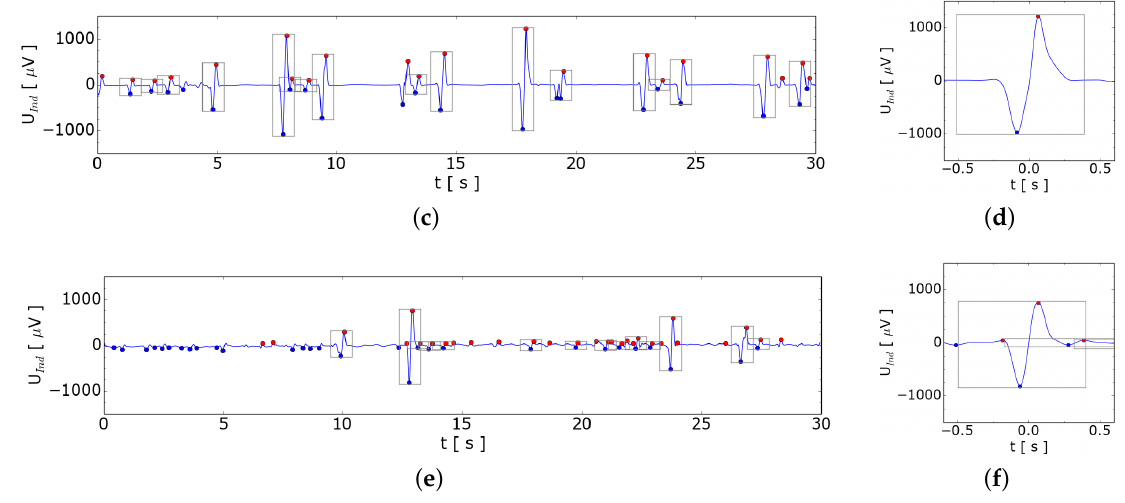
Figure 10. Bubble detection in sodium at rest and in motion, driven by an electromagnetic (EM)-pump. ( a , b ) Measured voltage when sodium is at rest with zoom at t = 31.4 s; ( c , d ) Measured voltage for sodium velocity of 6 cm/s with zoom at t = 17.8 s; ( e , f ) Measured voltage for sodium velocity of 14 cm/s with zoom at t = 12.8 s.